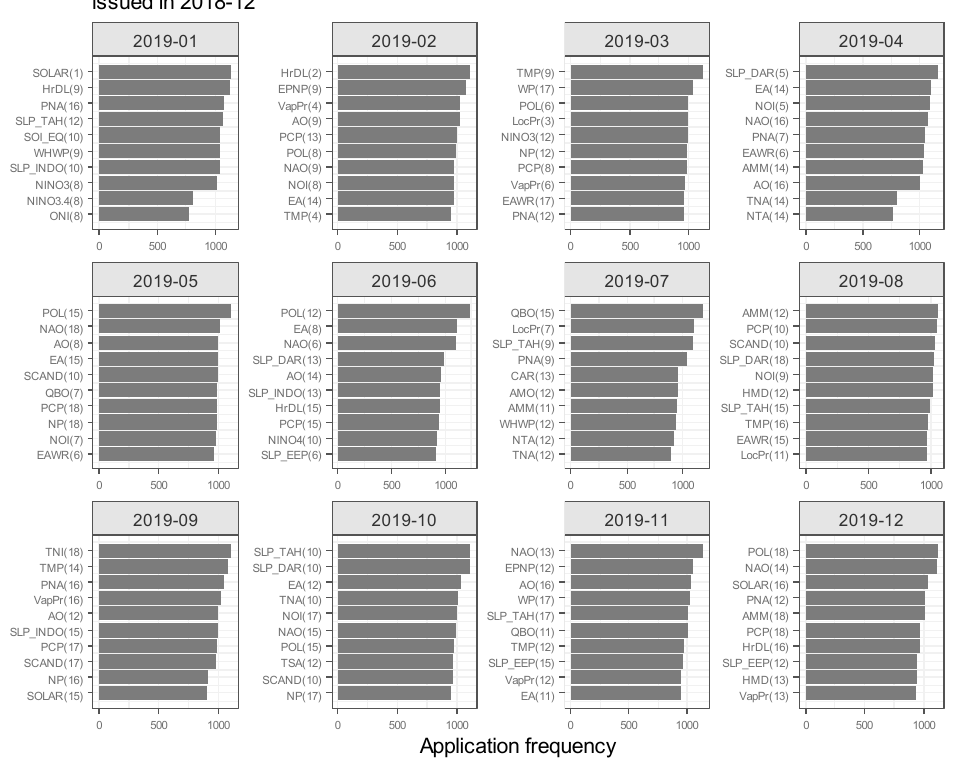
Figure 7. Application frequency of the climate indices used for monthly precipitation forecasting in 2019.